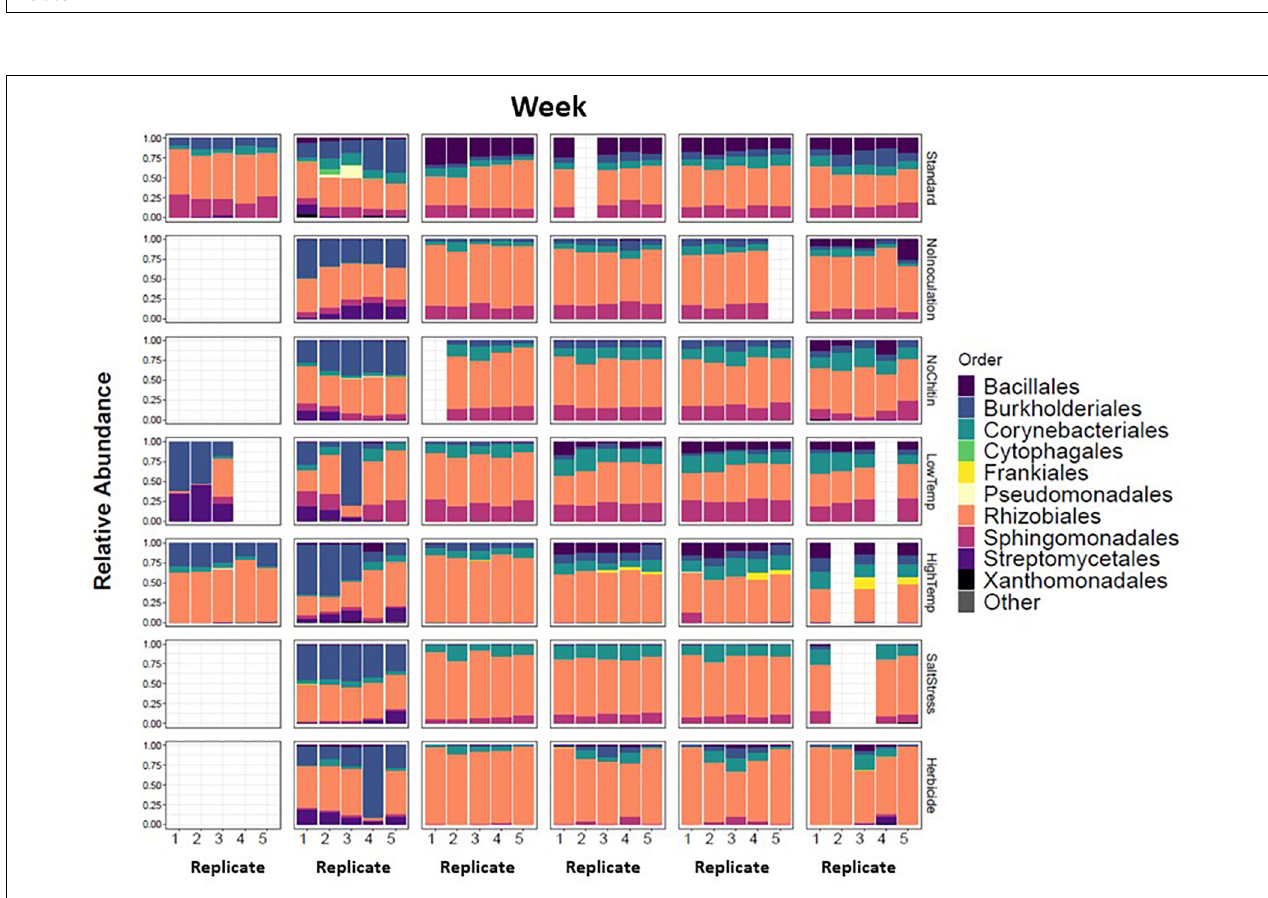
FIGURE 8 | Taxonomic shifts of MSC-1 during growth on chitin in soil. Relative abundance of each replicate during five week incubations is shown on the y-axes, weeks incubated are shown at the top and replicates on the x-axes. Columns are colored by Order, a taxonomic rank used because we now have more reduced complexity community and can look more closely than at the Phylum level used in earlier